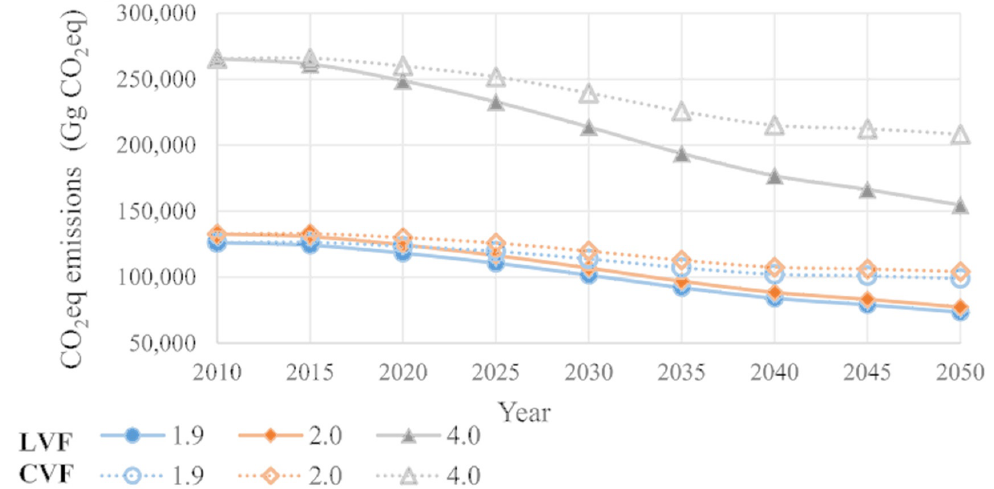
Figure 21. CO 2 eq emissions generated by fossil central power plants for three electricity demand per capita and two population models. Prepared by the authors based on own results.